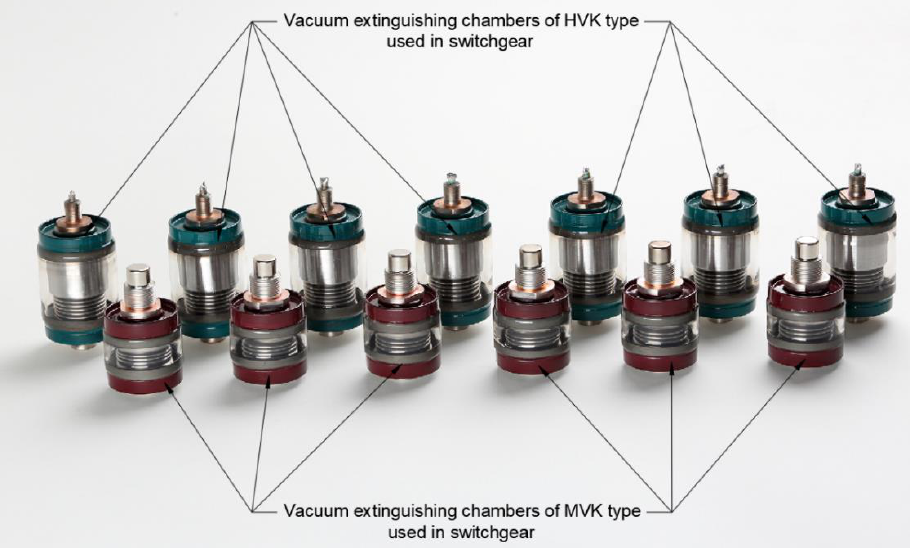
Figure 3. Vacuum chambers used in switchgear [49].